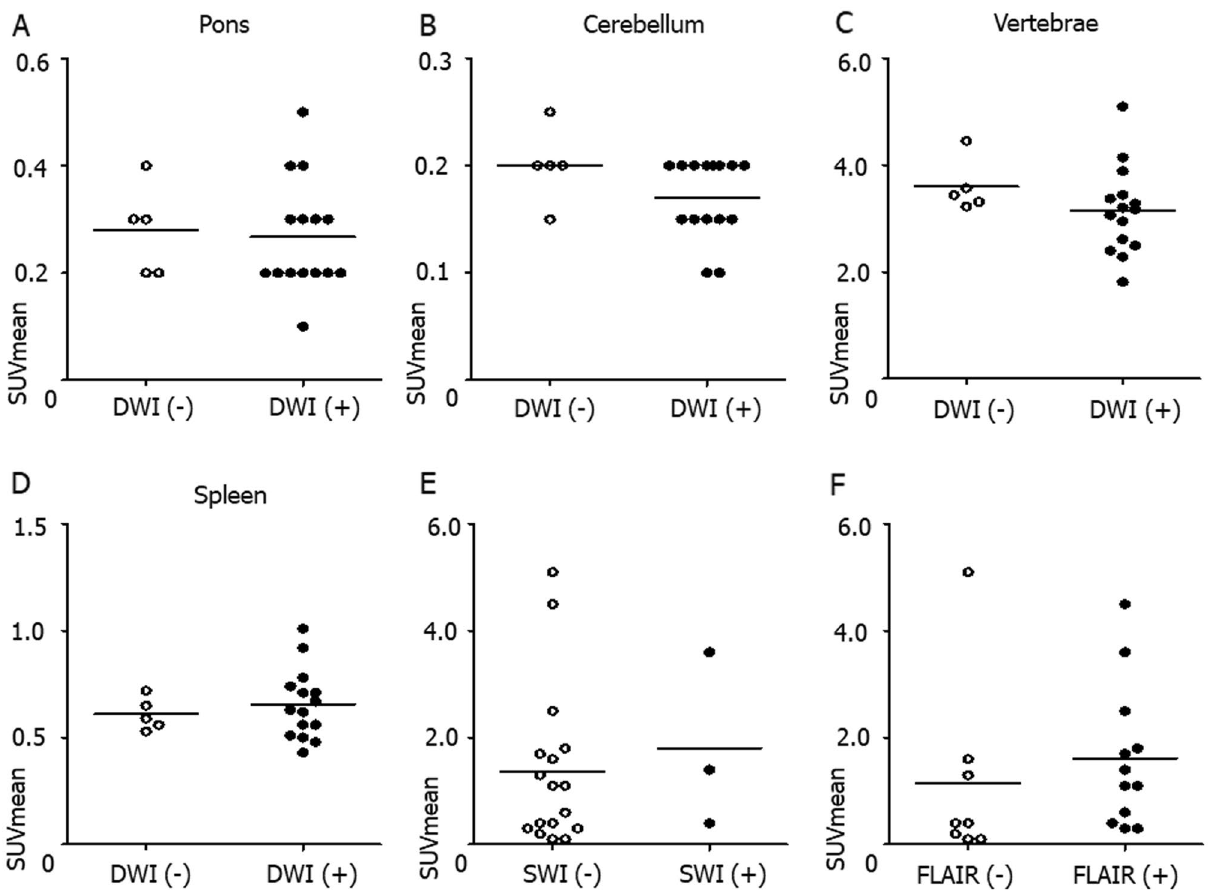
Figure 2. Comparison of NaF uptake according to diverse location and MRI protocol. When comparing NaF uptake in different brain areas and organs between the patients with and without diffusion positive lesions, its uptake intensity was not significantly different in the non-infarcted regions, such as pons (0.20 [0.20–0.30] versus 0.30 [0.20–0.30], p = 0.71, Mann–Whitney U test, A ), cerebellum (0.20 [0.20–0.25] versus 0.30 [0.25– 0.35], p = 0.16, Mann–Whitney U test, B ), lumbar vertebrae (3.17 [2.50–3.38] versus 3.44 [3.31–3.57], p = 0.19, Mann–Whitney U test, C ) or spleen (0.63 [0.51–0.71] versus 0.59 [0.53–0.65], p = 0.79, Mann–Whitney U test, D ). The NaF uptake was not significantly different in the SWI ( +) lesions (2.50 [1.40–3.60] versus 0.85 [0.30–1.70], p = 0.64, Mann–Whitney U test, E ) or FLAIR ( +) lesions (1.25 [0.40–2.50] versus 0.40 [0.15–1.45], p = 0.39, Mann–Whitney U test, F